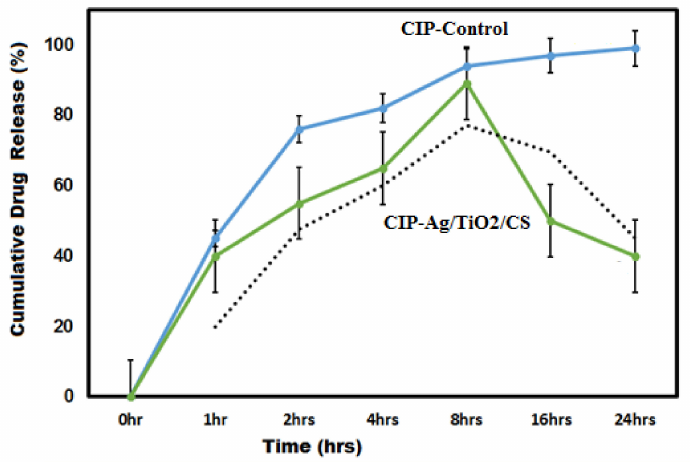
Figure 9. Ex vivo drug release profile of CIP-Ag/TiO 2 /CS nanohybrid in phosphate buffer solution (PBS, pH 7.4, 37 ◦